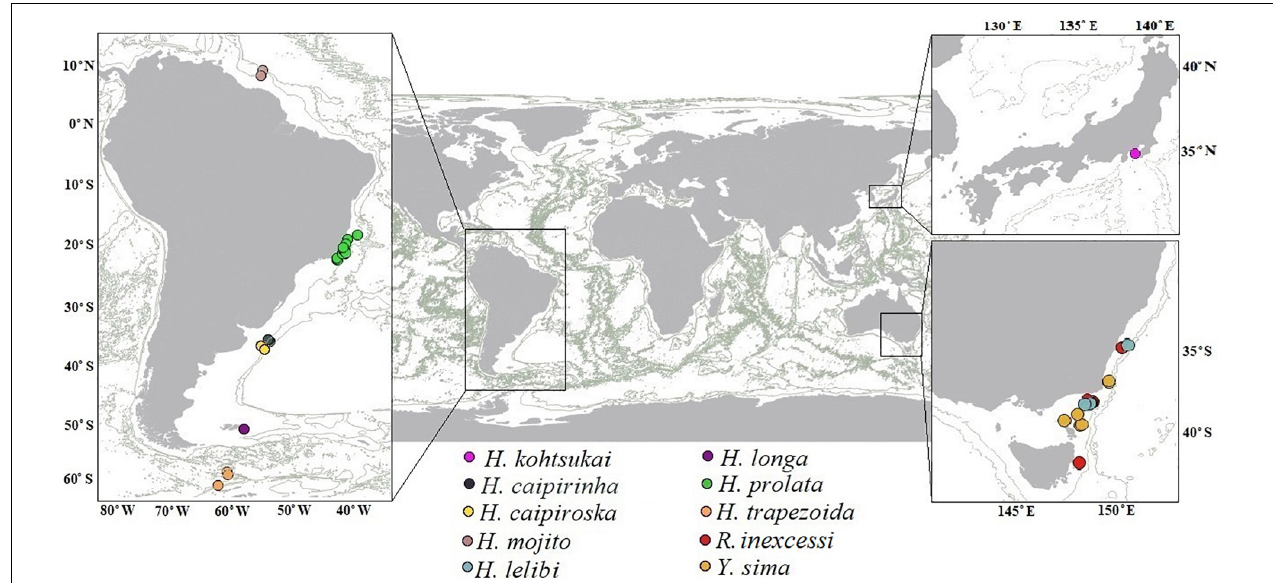
FIGURE 14 | Distribution of Hamatipedidae based on the present study and literature data (Bła˙zewicz-Paszkowycz, 2007; Bła˙zewicz-Paszkowycz and Bamber, 2012; Segadilha et al., 2019; Kakui and Hiruta, 2021).